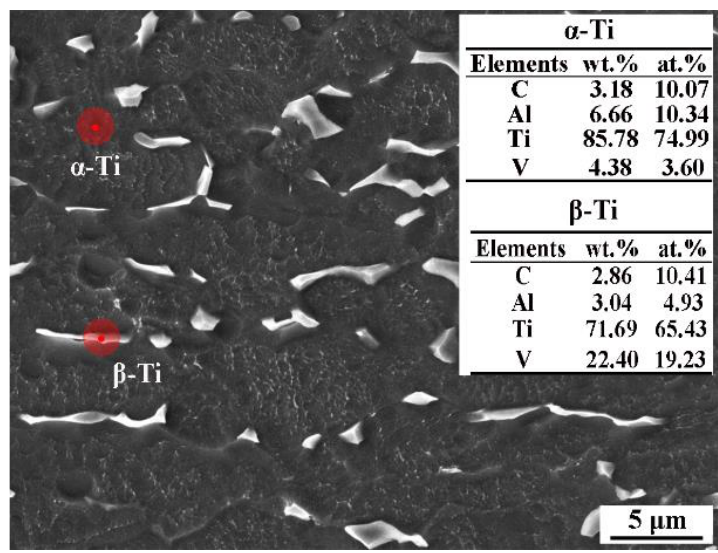
Figure 1. SEM micrographs and EDS results of Ti6Al4V substrate.